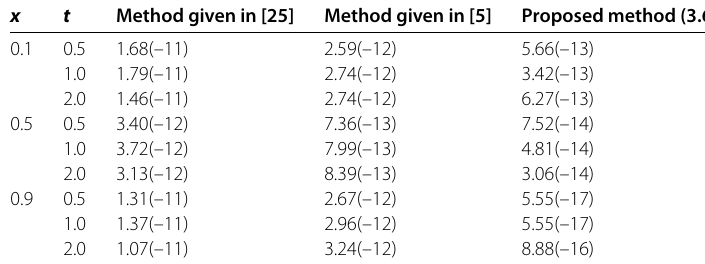
Table 7 Example 1: Case 1.3(a): Maximum absolute errors at δ = 1